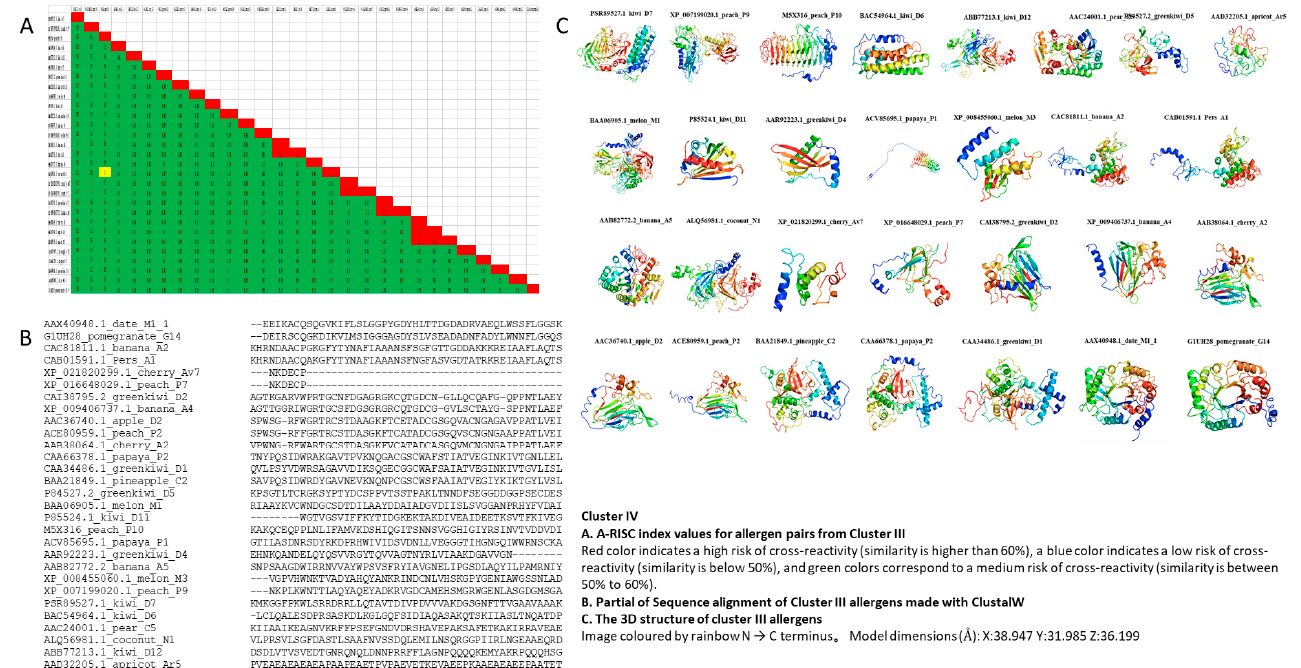
Figure 5. A-RISC index values, sequence alignment, and 3D structure of Cluster